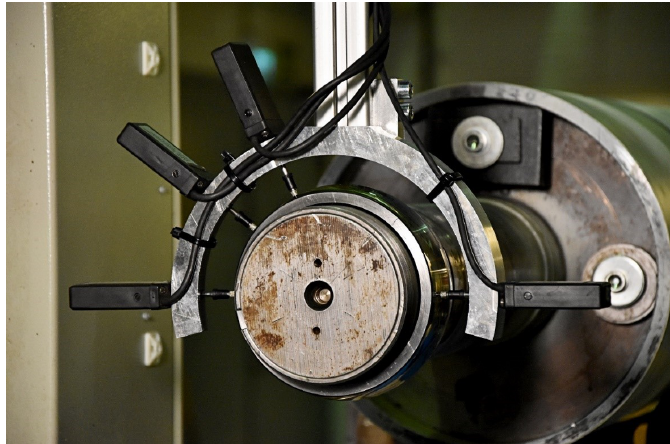
Figure 4. The bearing inner ring roundness profile was measured while installed on the rotor shaft [24].